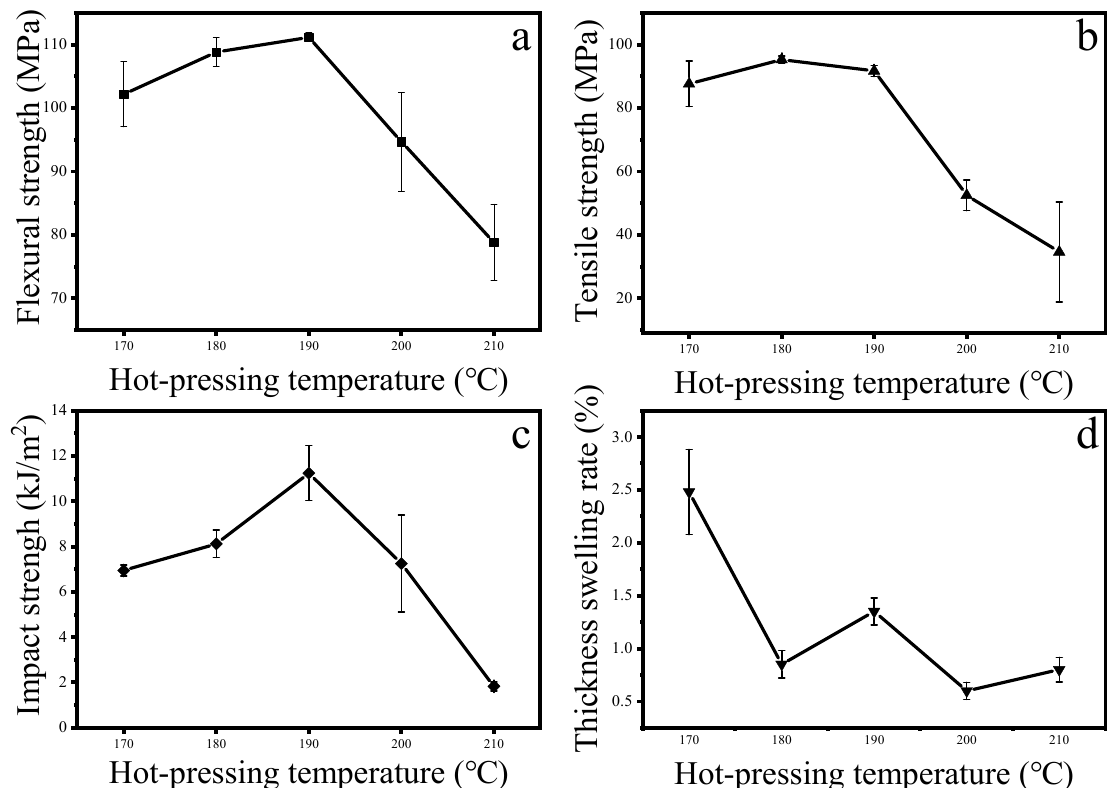
Figure 1. Effect of hot-pressing temperature on different properties of composite plates: ( a ) flexural strength; ( b ) tensile strength; ( c ) impact strength; ( d ) thickness swelling rate.